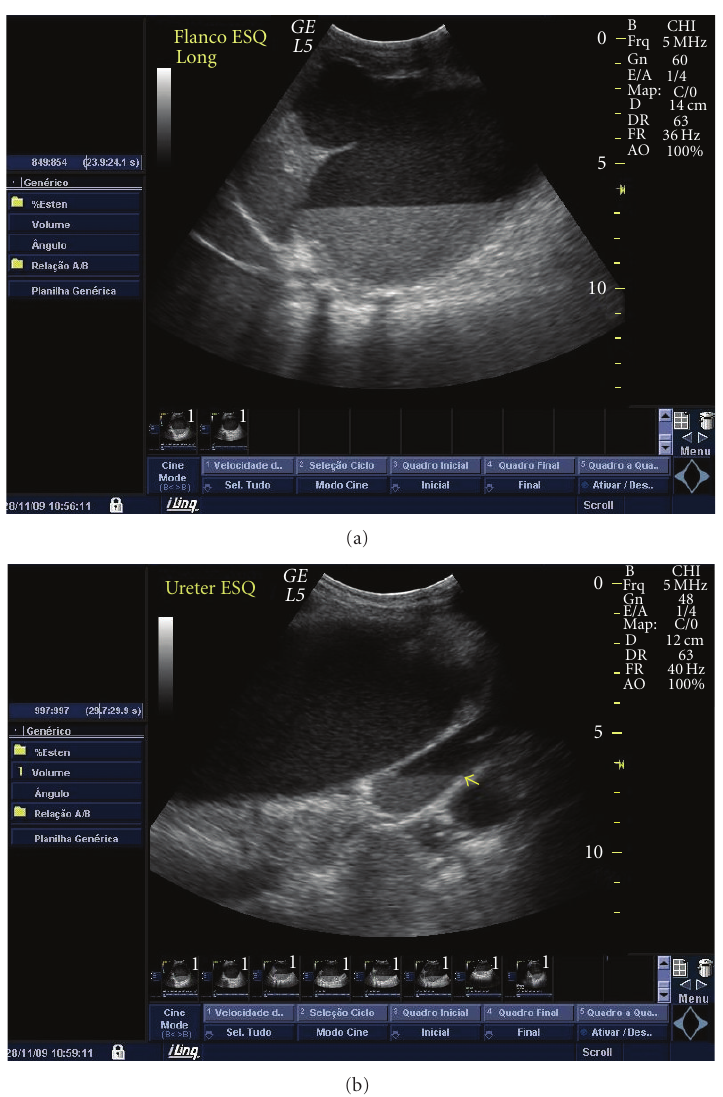
Figure 2: Abdomen ultrasound showing marked dilatation of the left pelvicalyceal system (a) and left ureter ((b) arrow), both containing hypoechoic fluid with posterior acoustic enhancement, and echogenic material deposited on the gravity-dependent portion with formation of fluid-fluid